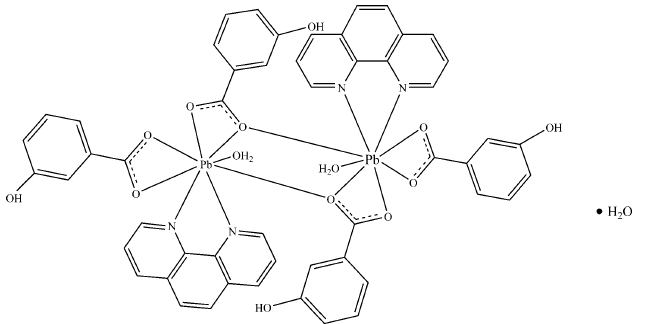
Hydrogen-bond geometry (A˚ , (cid:2)